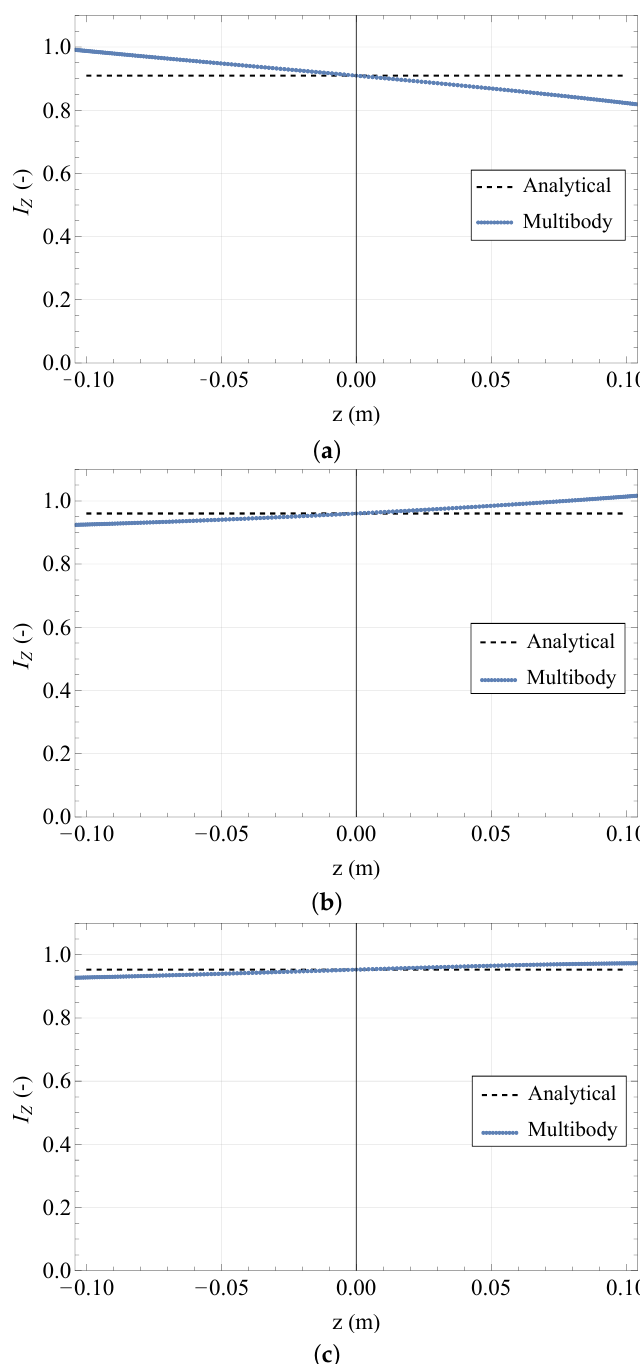
Figure 11. Comparison of the vertical installation ratio computed using analytical models and multibody models, ( a ) Swing axle, ( b ) McPherson, ( c ) Double